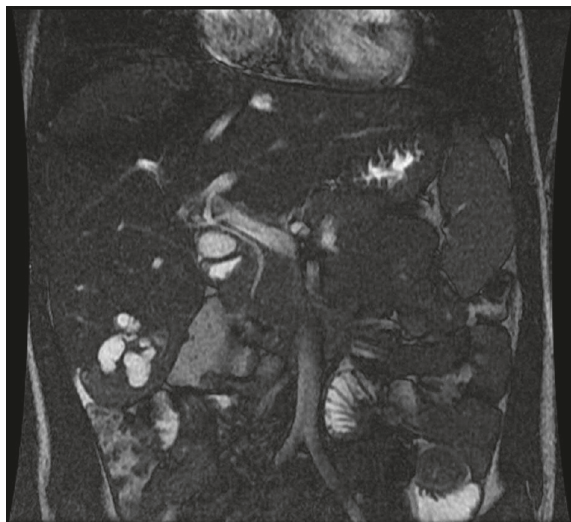
Figure 1: Clusters of multiple T2-bright circumscribed cystic le- sions in segment 6 measuring < 2cm in greatest dimension sug- gestive of mesenchymal hamartoma.